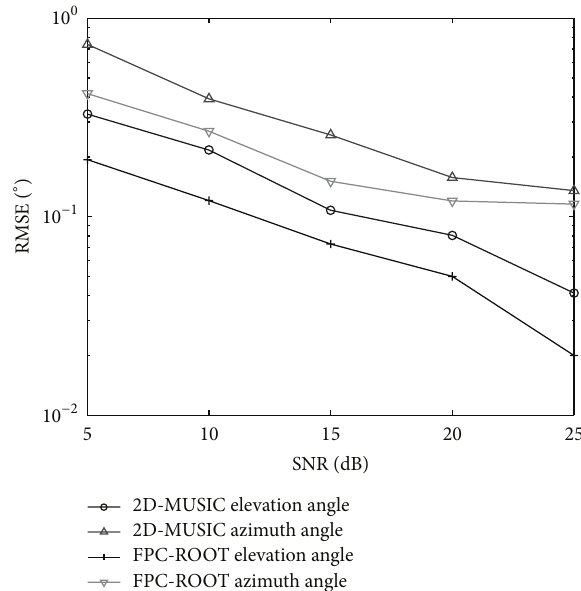
Figure 4: RMSE of 2D DOA estimation based on matrix comple- tion.